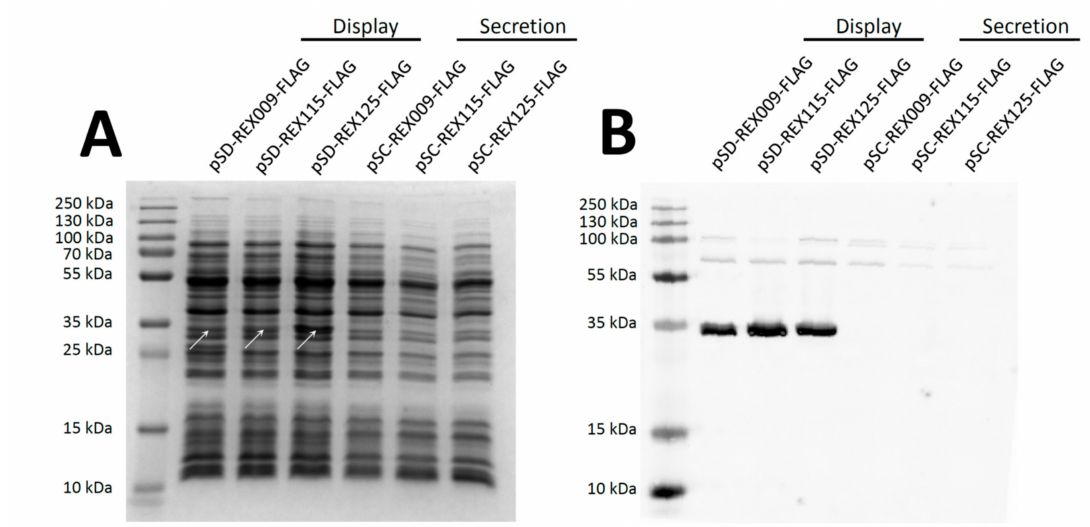
Figure 2. Detection of FLAG-tagged REX fusion proteins in the cell lysate of L. lactis . ( A ) SDS-PAGE stained with Coomassie Brilliant Blue. ( B ) Western blotting with an anti-FLAG-tag antibody. REX proteins are in fusion with the Usp45 secretion signal (Secretion), or with the Usp45 secretion signal and a cAcmA surface anchor (Display).